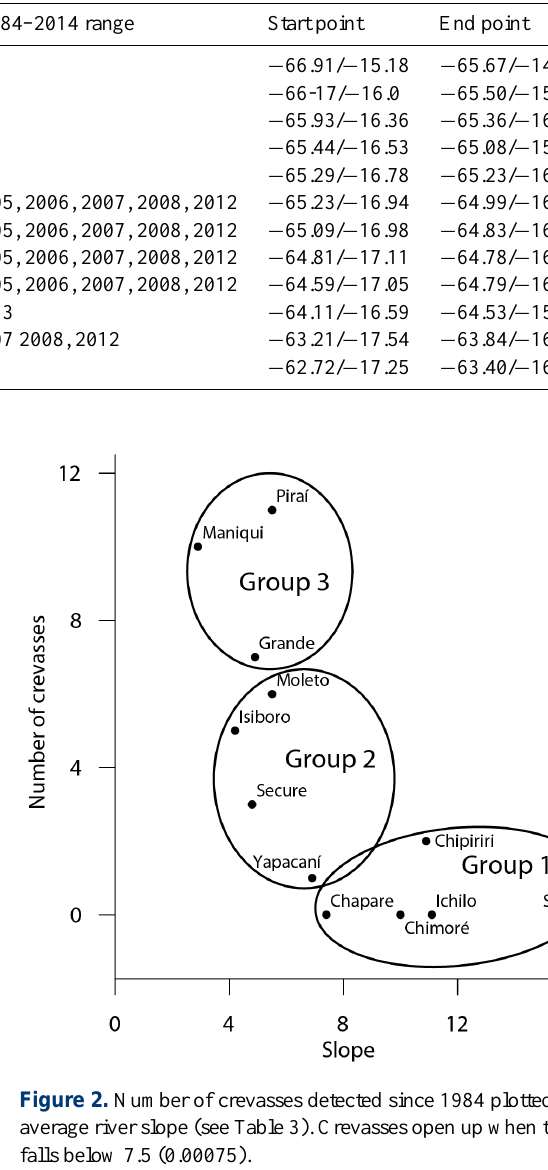
Table 1. Years for which images were not downloaded from the USGS service LandsatLook. Images taken in the years within the 1984–2014 range not listed in the second column have been downloaded and used.